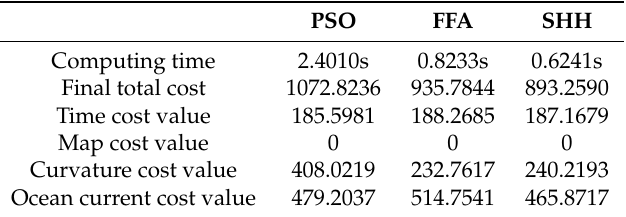
Table 4. Results comparison using PSO, FFA and SHH algorithms in Scenario 3.